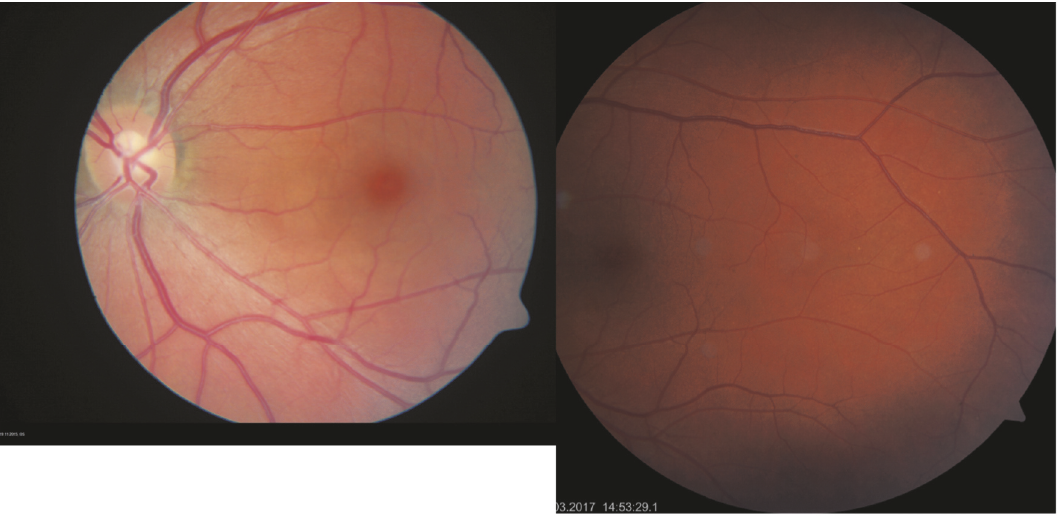
Figure 1: Color fundus photography of the left eye.